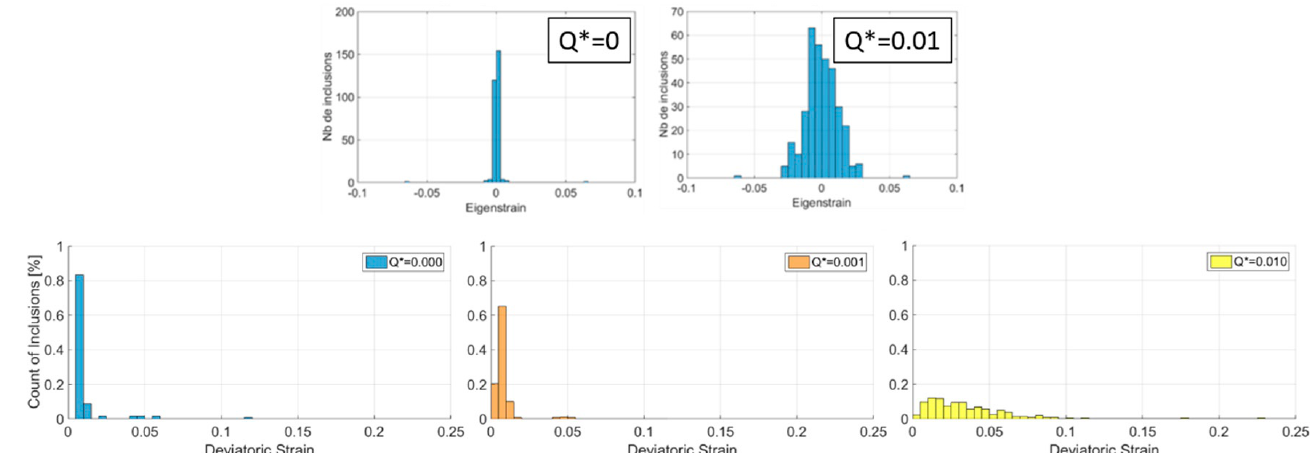
Figure 6. Top: Distribution of eigenstrains ε * in the sample for different values of Q*, at steps 25 with 10 events at each steps, with S = 0.10 and Q = 0. Bottom: Global distribution of deviatoric strains ε d in the sample, for the same conditions. With our choice of loading F z , the maximum deviatoric strain ε d max due to Hertz contact in the absence of disorder was equal to 0.65 × 10 − 2 here.